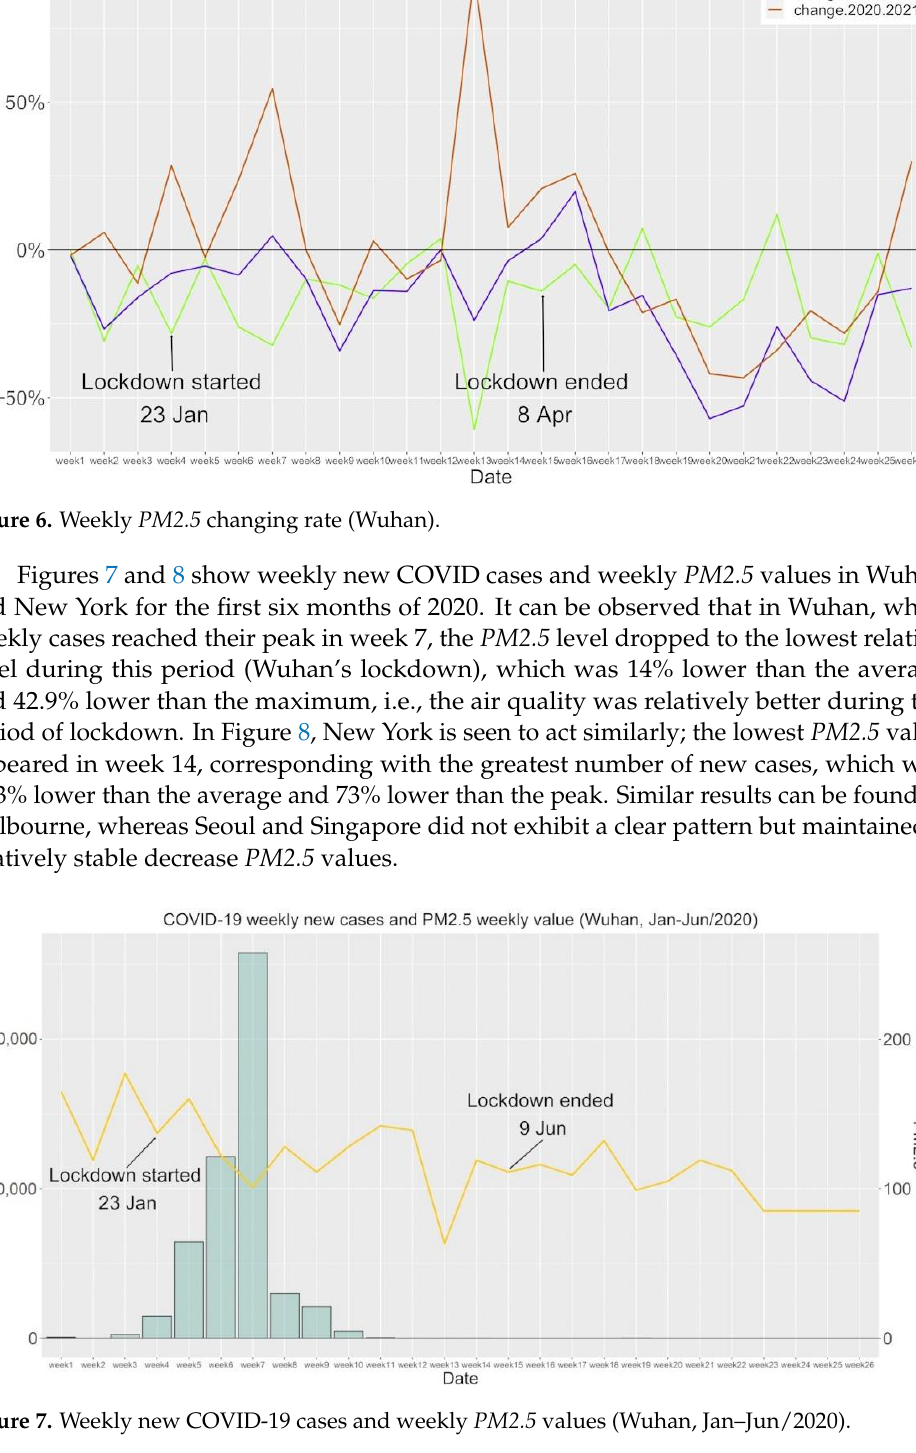
Figure 8. Weekly new COVID-19 cases and weekly PM2.5 values (New York, Jan-Jun/2020). It can be seen from Figures 9 and 10 that PM2.5 dropped in all cities from 2019 to 2020, except for Melbourne. Wuhan had the most significant drops (negative values). In Figure 9, the blue columns representing the change from 2020 to 2021 are all positive; from 2019 to 2021, Wuhan, Seoul, and Singapore are negative, and New York and Melbourne are positive. Figure 10 is a subset of Figure 9, and it shows only four cities during lock- down periods (there was no lockdown in Seoul). Comparing data from Figures 9 and 10, the yearly changing rates from 2019 to 2020 were −1 7.81% and −1 6.03% in Wuhan, −1 1.72% and −8 .47% in New York, and −1 5.17% and −9 .56% in Singapore. For details, please refer to Tables 3 and 4. Cities that implemented closures tended to have greater yearly PM2.5 changing rates than those without lockdowns, with the exception of Melbourne.